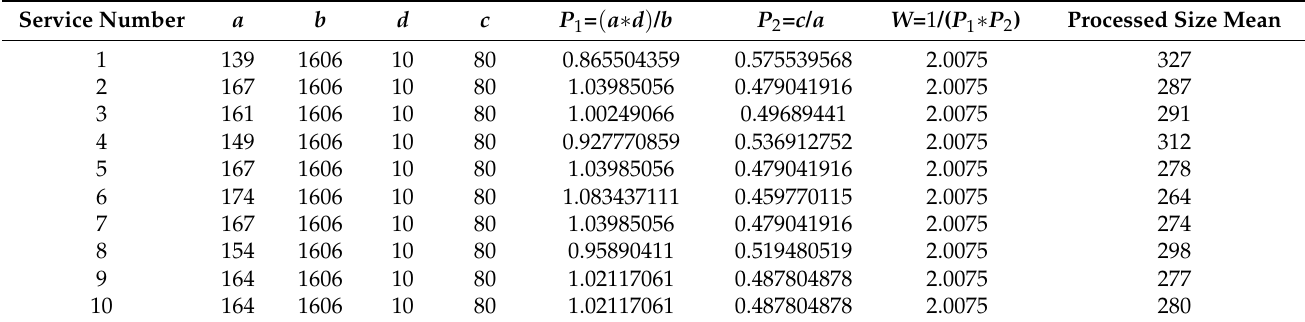
Table 3. Tracking PPS parameters per second at a sample size of 80 for